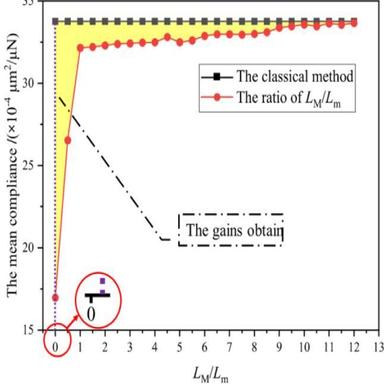
The Constitutive constants for optimal RVE solids and L M /Lm.